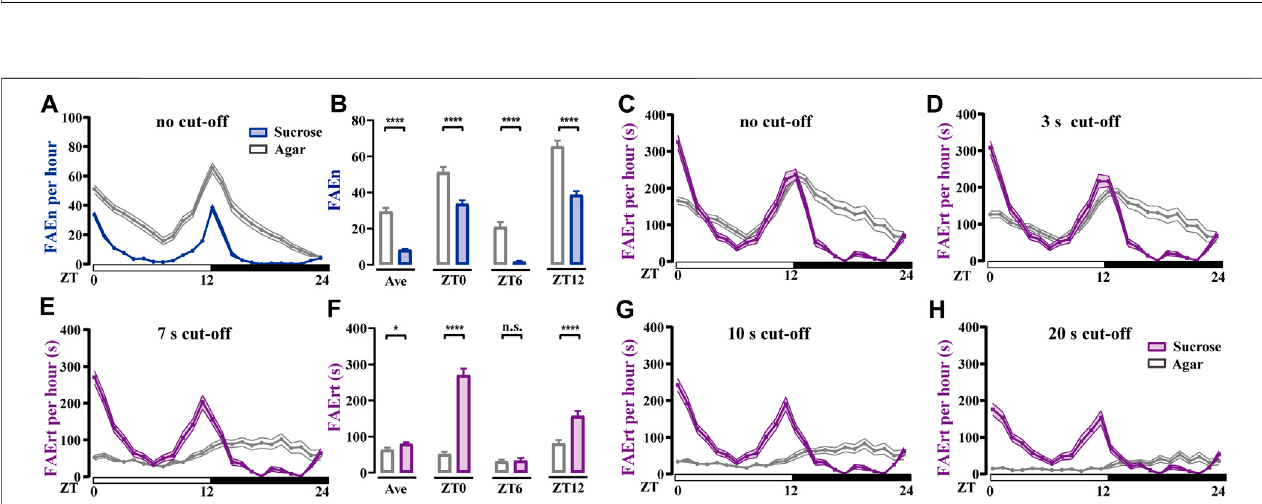
FIGURE4 | Food-approaching behavior exhibits different pro fi les in wild-type w 1118 male fl ies (A) Fliesin theagar group display higher levels ofFAEn compared to FAEnin fl iesinthesucrosegroup.ThenumbersofFAEweremergedeveryhourandareshownincurves (B) TheaverageFAEnperhourofthewholedayandtheFAEnin ZT 0,6, and 12 (C – E,G – H) The curves ofFAErtwith eitherno cut-off (C) or withcut-off asindicated (F) The averageFAErtper hourofthewhole day andthe FAErtin ZT 0, 6, and 12. Data are shown as means ± SEM. * p < 0.05; **** p < 0.0001. n. s. indicates no signi fi cant difference. n (cid:1) 78 in the agar group and 86 in the sucrose